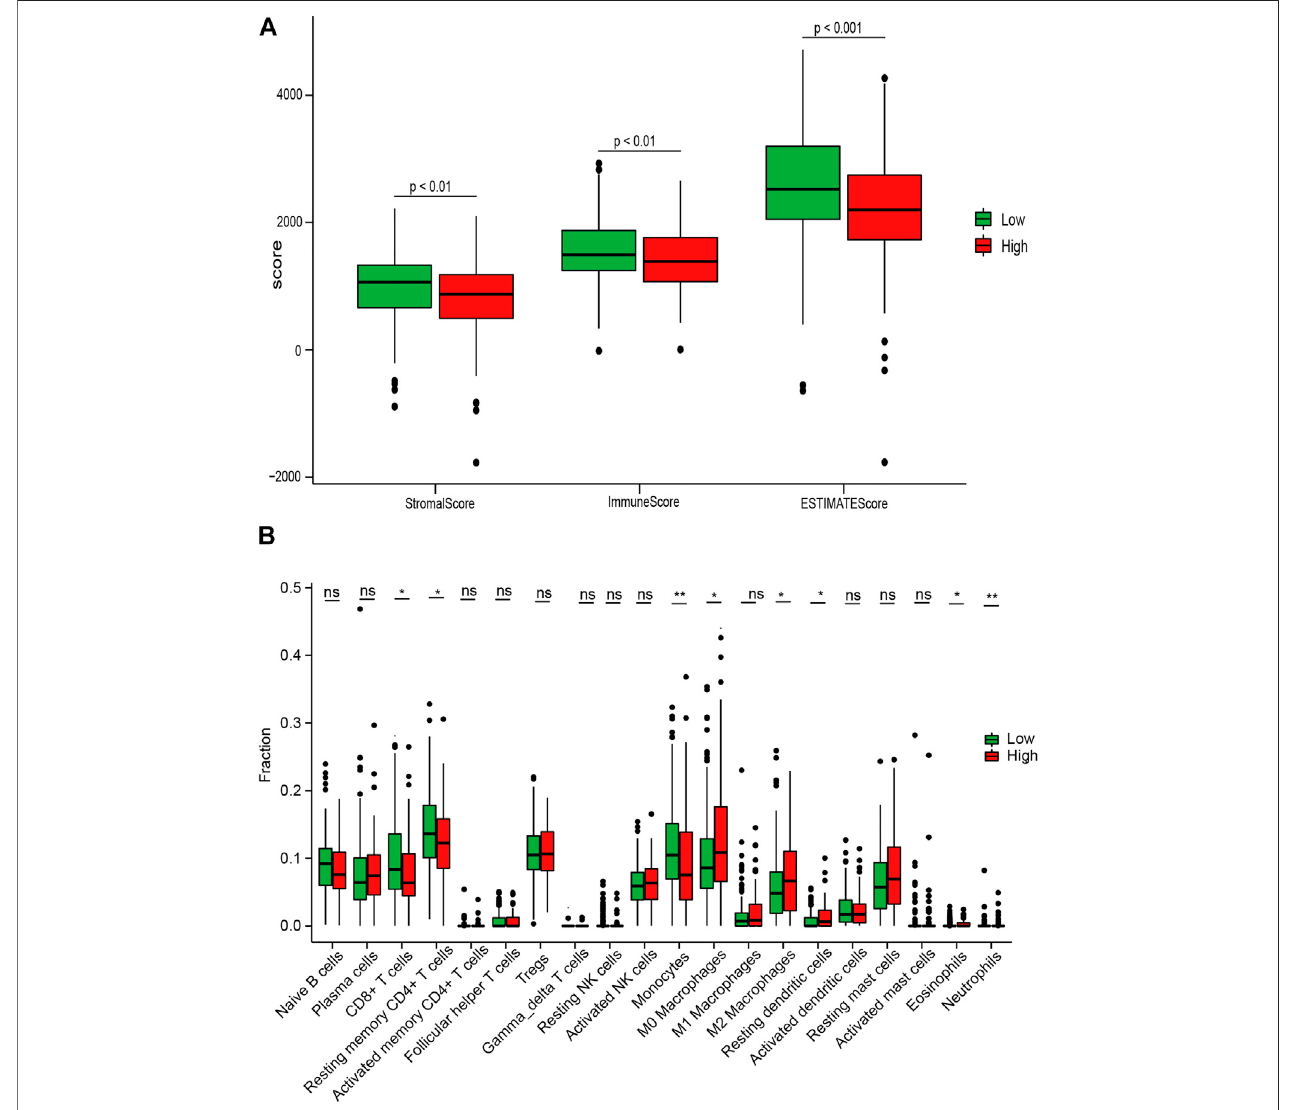
FIGURE 6 | Associations between the IRGS and the tumor microenvironment. (A) Relationship between the risk score and the ESTIMATE score, stromal score, and immune score. (B) Distribution level of 22 tumor-in fi ltrating immune cells in the high- and low-risk groups. ns, no signi fi cance, * p < 0.05, ** p < 0.01, *** p < 0.001.